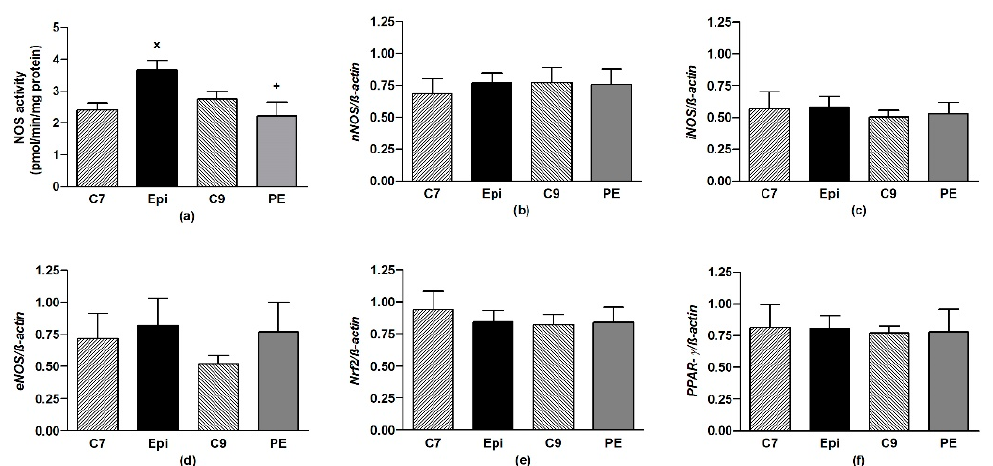
Figure 4. The effect of (–)-epicatechin on the nitric oxide synthase (NOS) activity ( a ) and gene expression of neuronal nNOS ( b ), inducible iNOS ( c ), endothelial eNOS ( d ), Nrf2 ( e ) and PPAR- γ ( f ) in the left heart ventricle of borderline hypertensive rats. The values represent the mean ± SEM, n = 6–7 per group. x p < 0.05 vs. C7 group, + p < 0.05 vs. Epi group. Abbreviations. C7: seven-week-old control group, C9: nine-week-old control group, Epi: (–)-epicatechin group, PE: (–)-epicatechin post-treatment group, Nrf2 : nuclear factor erythroid 2-related factor 2, PPAR- γ : peroxisome proliferator-activated receptor gamma.